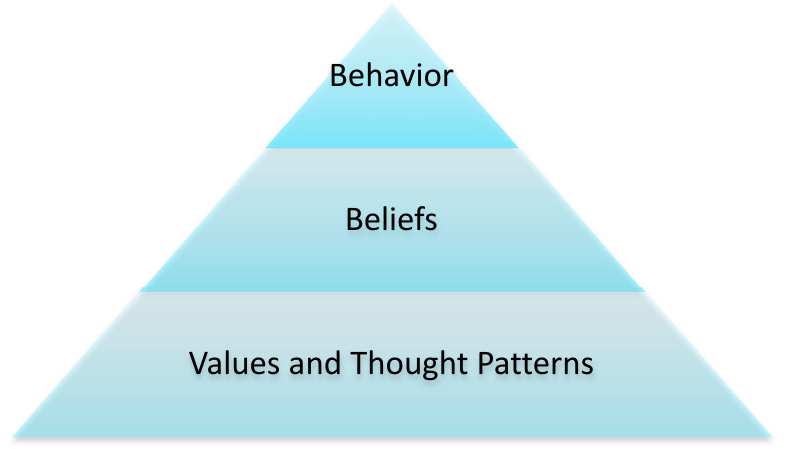
Figure 2. Cultural iceberg model [38].